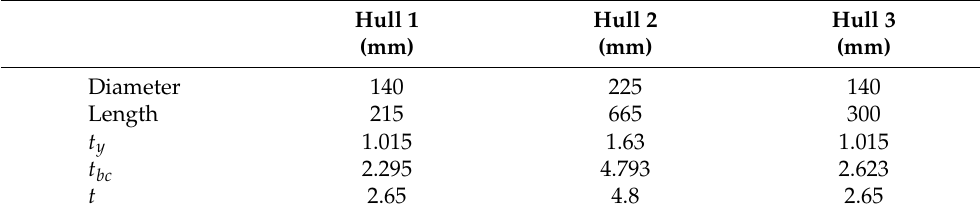
Table 1. Wall thickness given by yield and buckling criteria for each